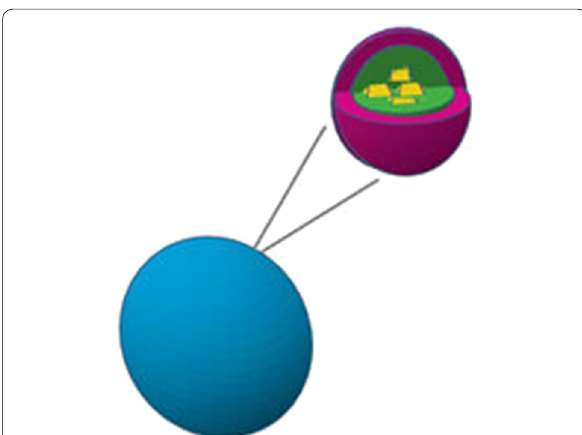
Fig. 1 Representation of the bead encapsulation components in cross‑section. The blue color refers to the chitosan, purple the Ca‑alginate, green the internal matrix and yellow represents the